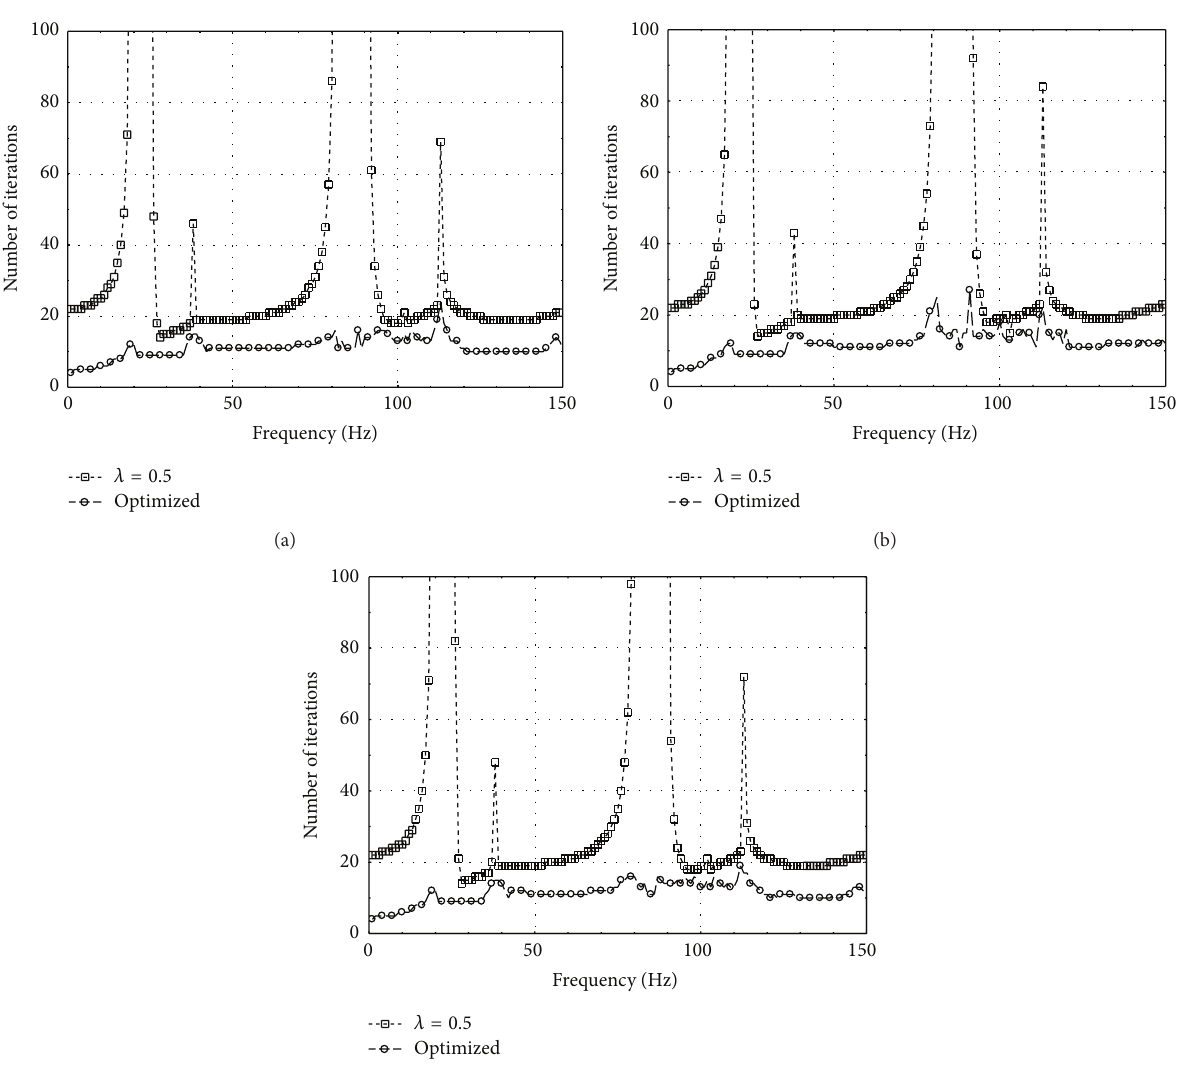
boundary conditions. For the solid, full-space